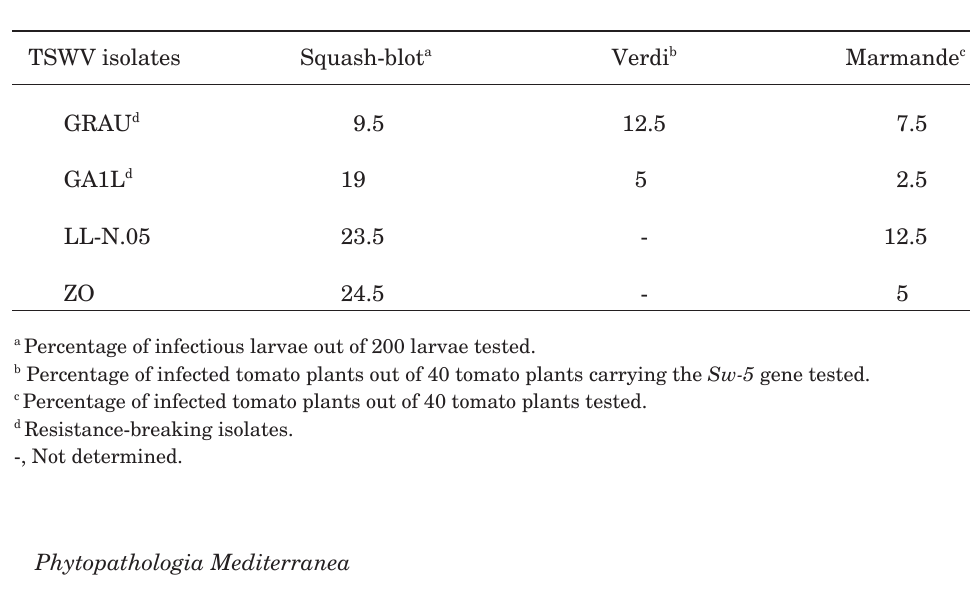
Table 2. Correlation between Tomato spotted wilt virus (TSWV) in larvae after feeding on Datura stramonium in- fected plants determined by squash-blot on nitrocellulose membranes and their capacity to transmit different TSWV isolates to tomato plants with or without Sw-5